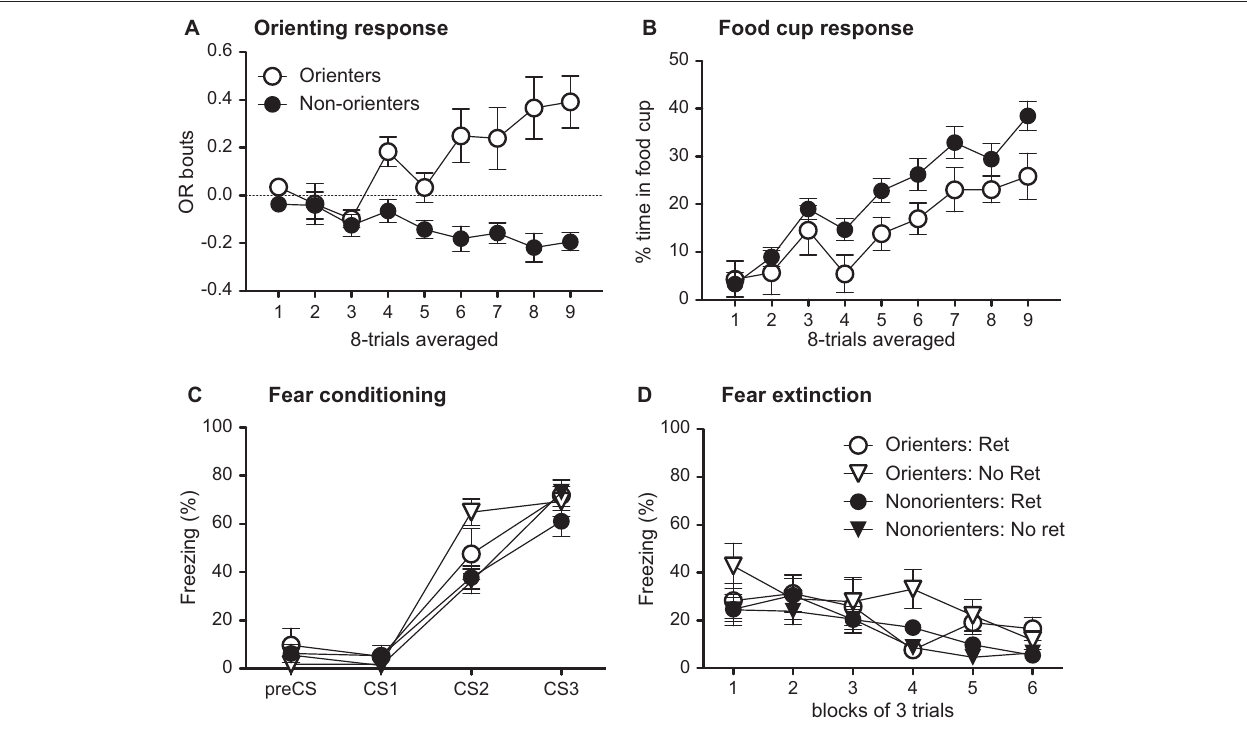
to fear conditioning. Both Orienters and Nonorienters acquired conditioned food cup response (B) while only Orienters showed conditioned OR (A) . Both Orienters and Nonorienters achieved comparable freezing levels by the end of fear conditioning trials (C) and displayed similar extinction rates (D) regardless of retrieval condition. However, the Orienters-No Retrieval group showed slightly increased freezing levels both during acquisition and extinction